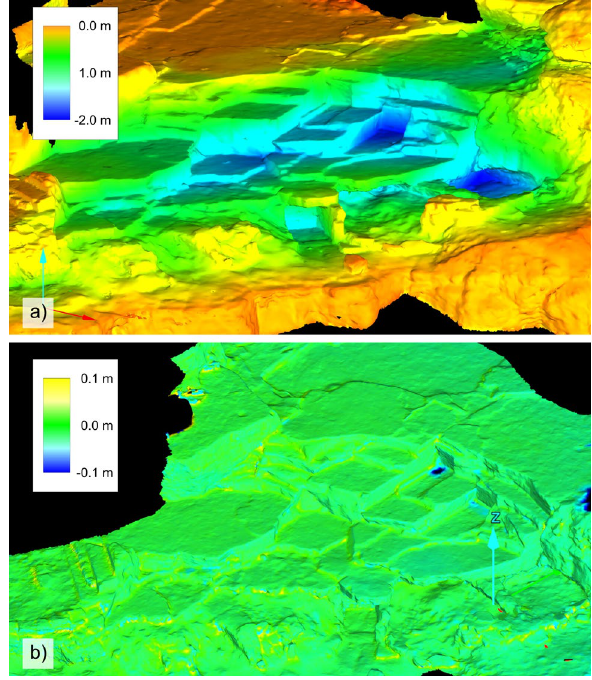
Figure 6. Comparison between 3D models: a) CRP (2017) vs CRP (2019); b) CRP (2019) vs TLS (2019). Secondly, the comparison between the model obtained in 2019 based on CRP and that obtained using TLS has shown low discrepancies (Figure 6b), with an average value of about 0.003 m and an RMSE value of 0.011 metres. We used a sample of more than 142000 points to compare both models. The discrepancies are mainly based on the interpolation performed in small zones without data, the different software used for triangulation and the usual smoothness of the models obtained using CRP with respect to TLS. However the results obtained demonstrate that both meshes are quite similar (even the mean value of the differences is lower than data resolution).